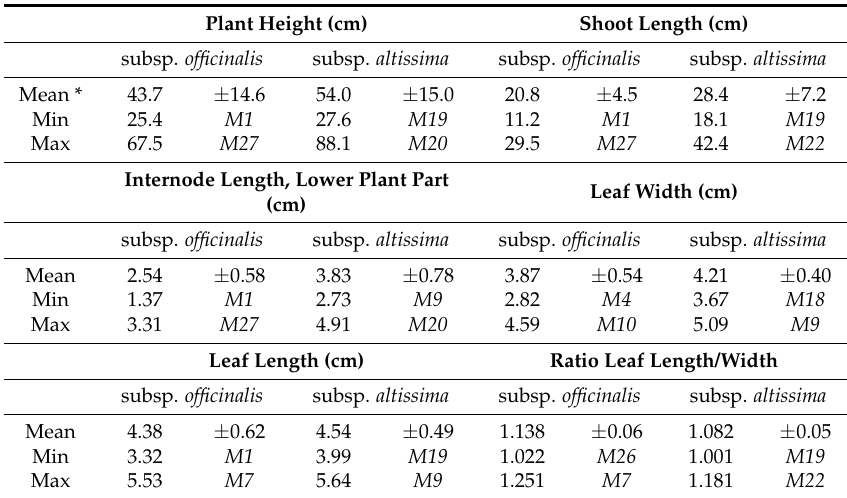
Table 1. Variability of morphological characters in lemon balm. Plant Height (cm) Shoot Length